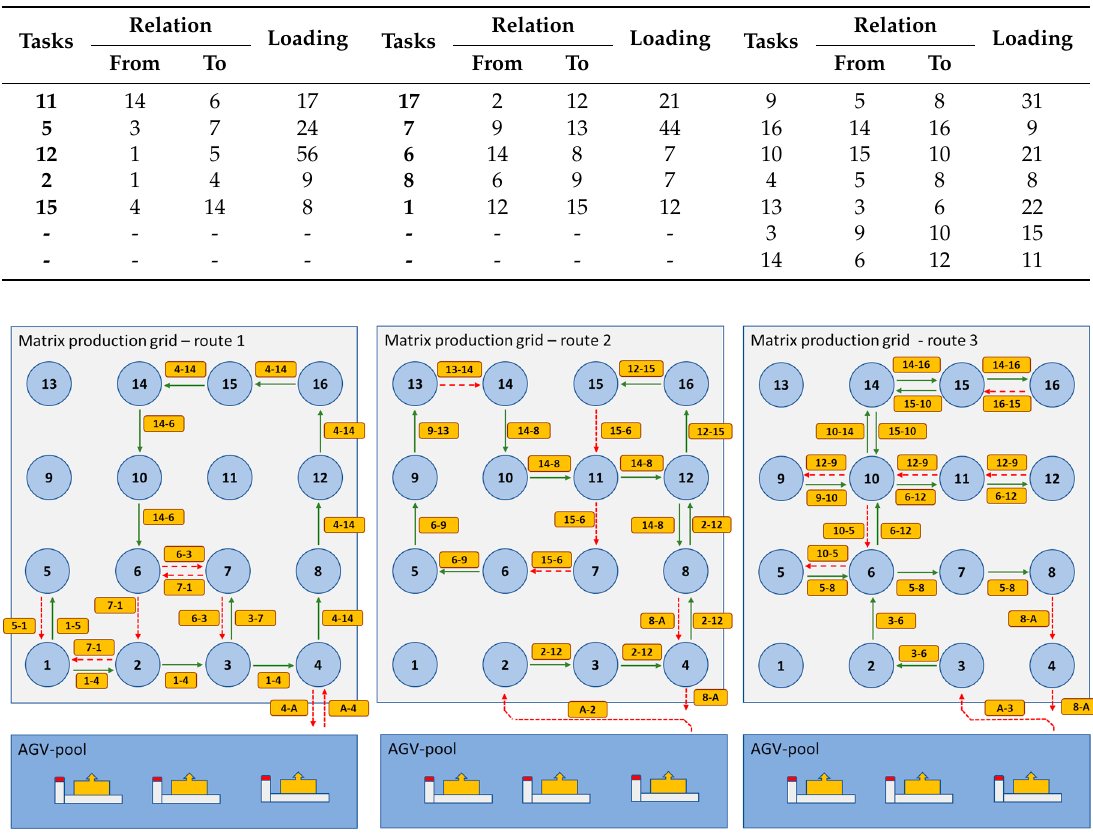
Figure 17. Results of real-time reclustering, reassignment, and rerouting of AGVs.